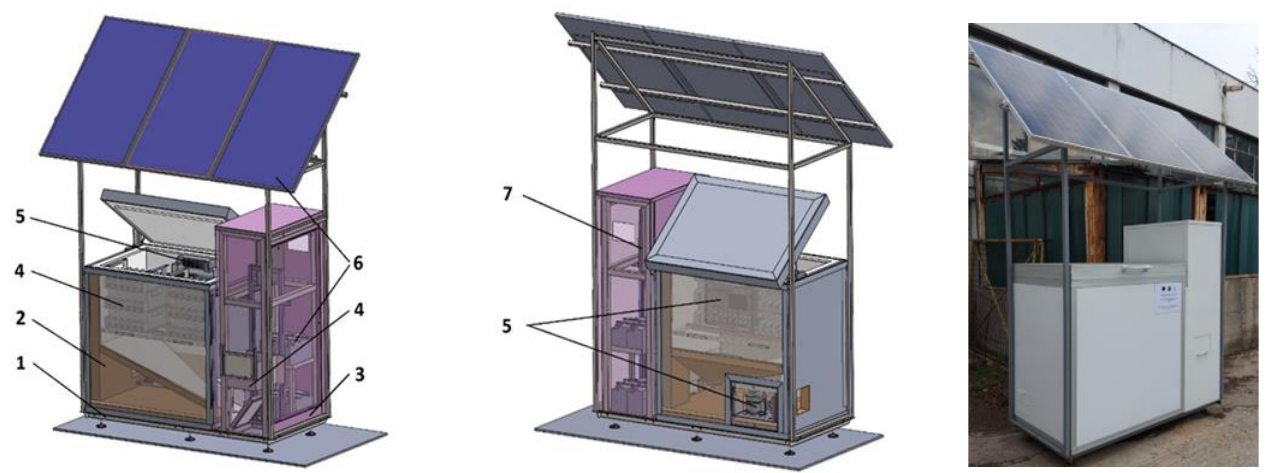
Figure 1. Experimental model subsystems.